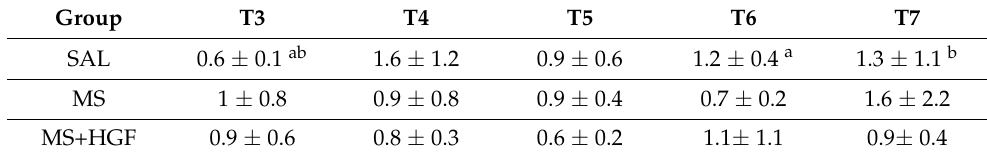
Table 6. IFN- γ . Mean values ± standard deviations of cytokine IFN- γ (pg/mL).